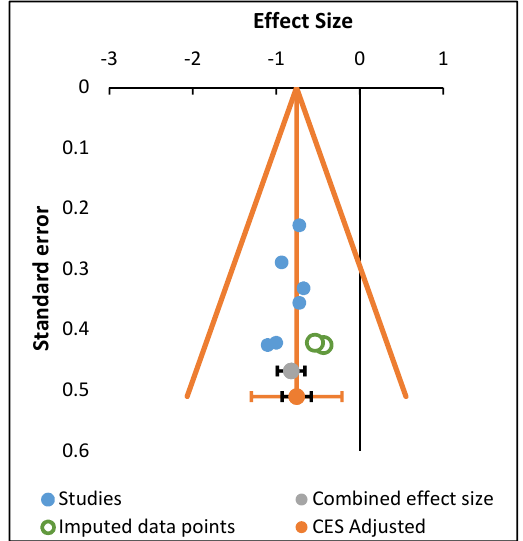
Figure 2. Trim and Fill funnel plot (Role Emotional).